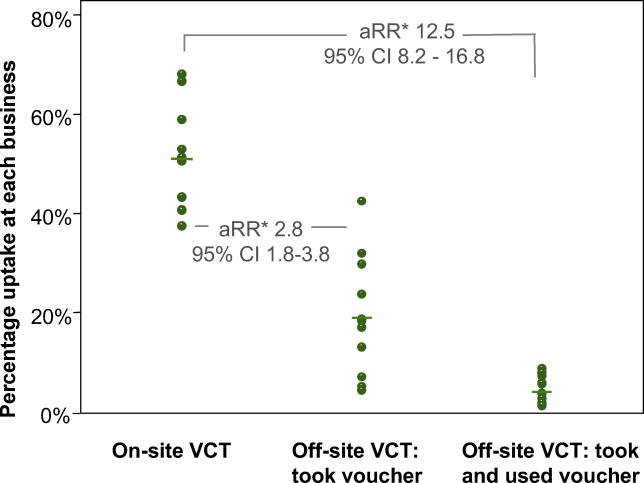
Uptake of VCT or Vouchers (Percentage) by Site and Allocated VCT StrategyEach point represents uptake at one business. The horizontal bars denote the mean site uptake within each category. aRR, risk ratio adjusted for age, sex, marital status, education, household contact with TB patients, self-rated health, and randomisation strata (see
Table 2).